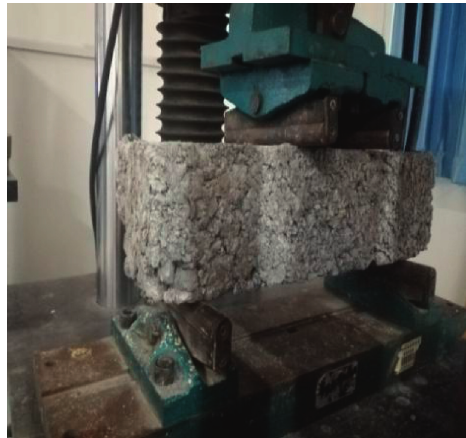
Figure 5: Flexural strength test.